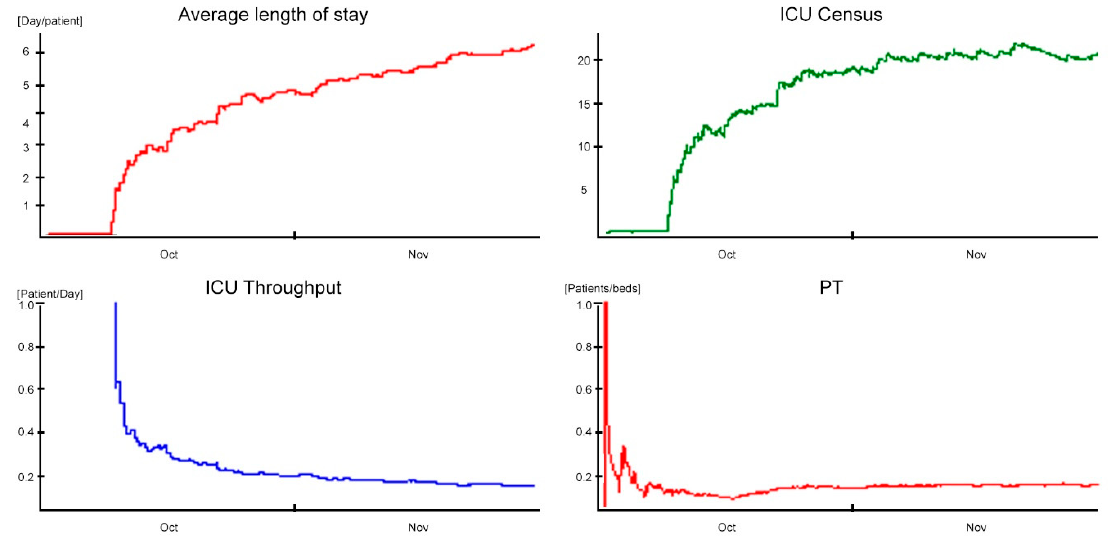
Figure 10. Outcomes in cell design scenario.